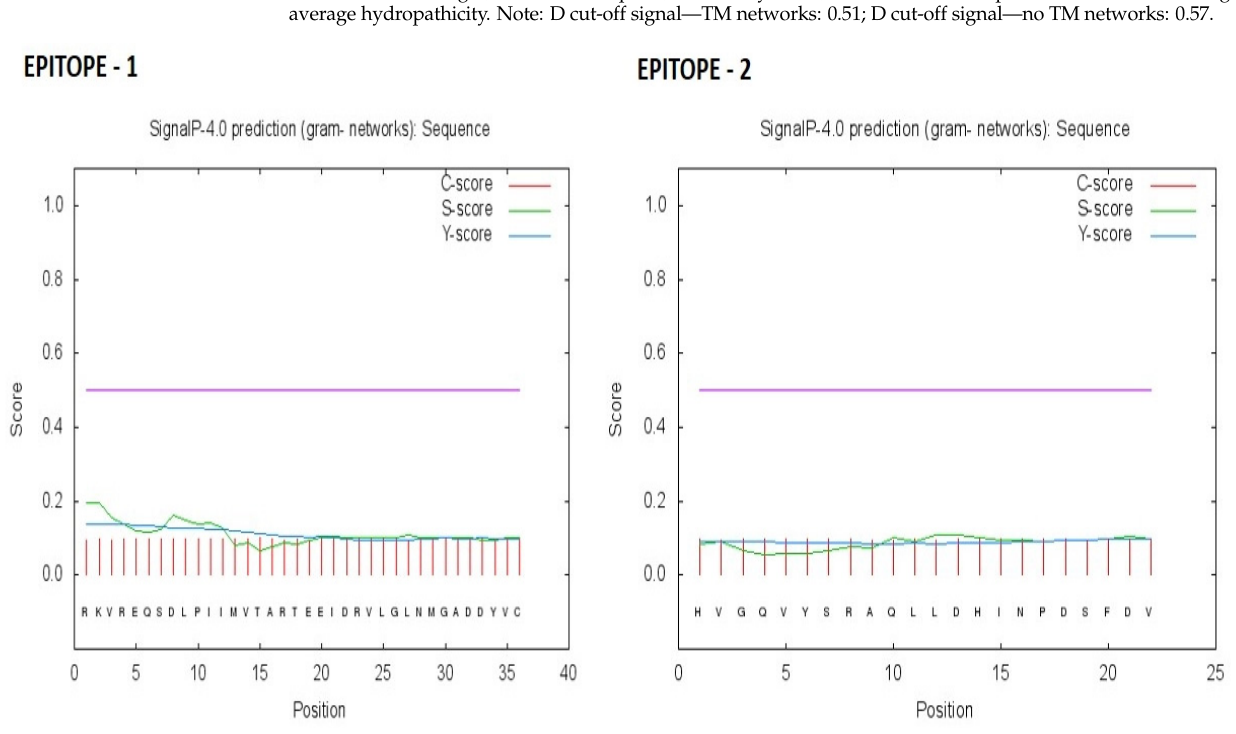
Figure 2. Signal P—no TM neural predictions (D cut-off value) using Signal P 4.0 server (C score—pink, S score—green and Y—blue, Purple—cut off value.).